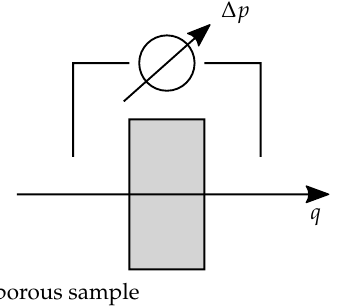
Figure 2. Measurement principle of the flow resistivity